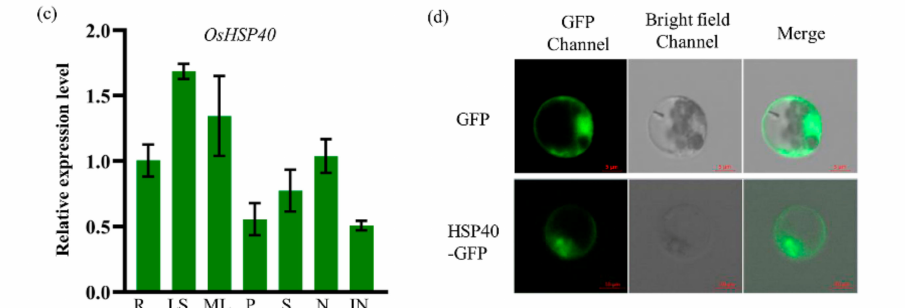
Figure 5. Characterization of OsHSP40 and its expression pattern. ( a ) Protein sequence alignment of OsHSP40 in different plants. Full-length of amino acid sequences from NCBI were used for analyses. ( b ) Phylogenetic tree showing the relationship between OsHSP40 homologs in monocots (Group A) and dicots (Group B). ( c ) Relative expression of OsHSP40 in various rice tissues determined by quantitative RT-PCR in wild type Zhenggeng 1925. R, roots; LS, leaf sheath; ML, mature leaves; P, panicles (10–15 cm); S, seeds (11–20 days after pollination); N, nodes; IN, internodes. Expression is relative to that in the root, the value of which was set as 1. OsActin gene was used as the internal